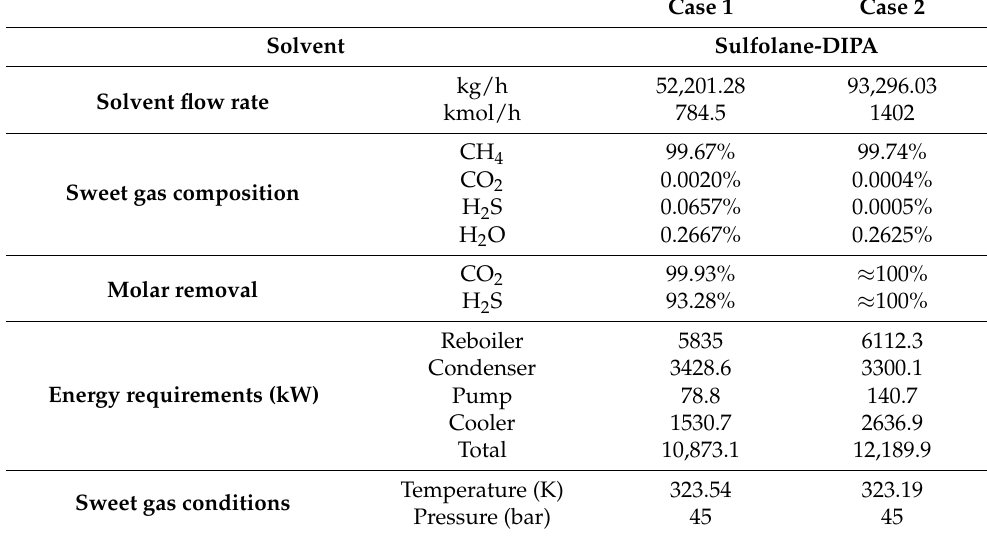
Table 3. Optimized results of the amine-sweetening unit.